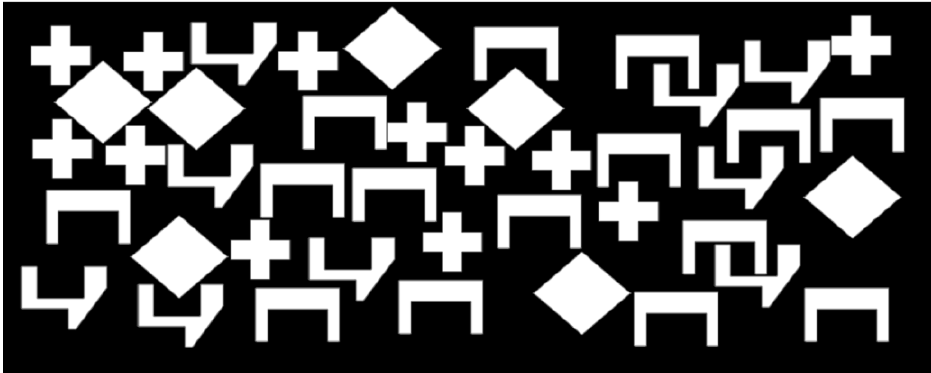
Figure 7. Solution found by the ILS algorithm using 43 pieces for the Shape 0 instance.